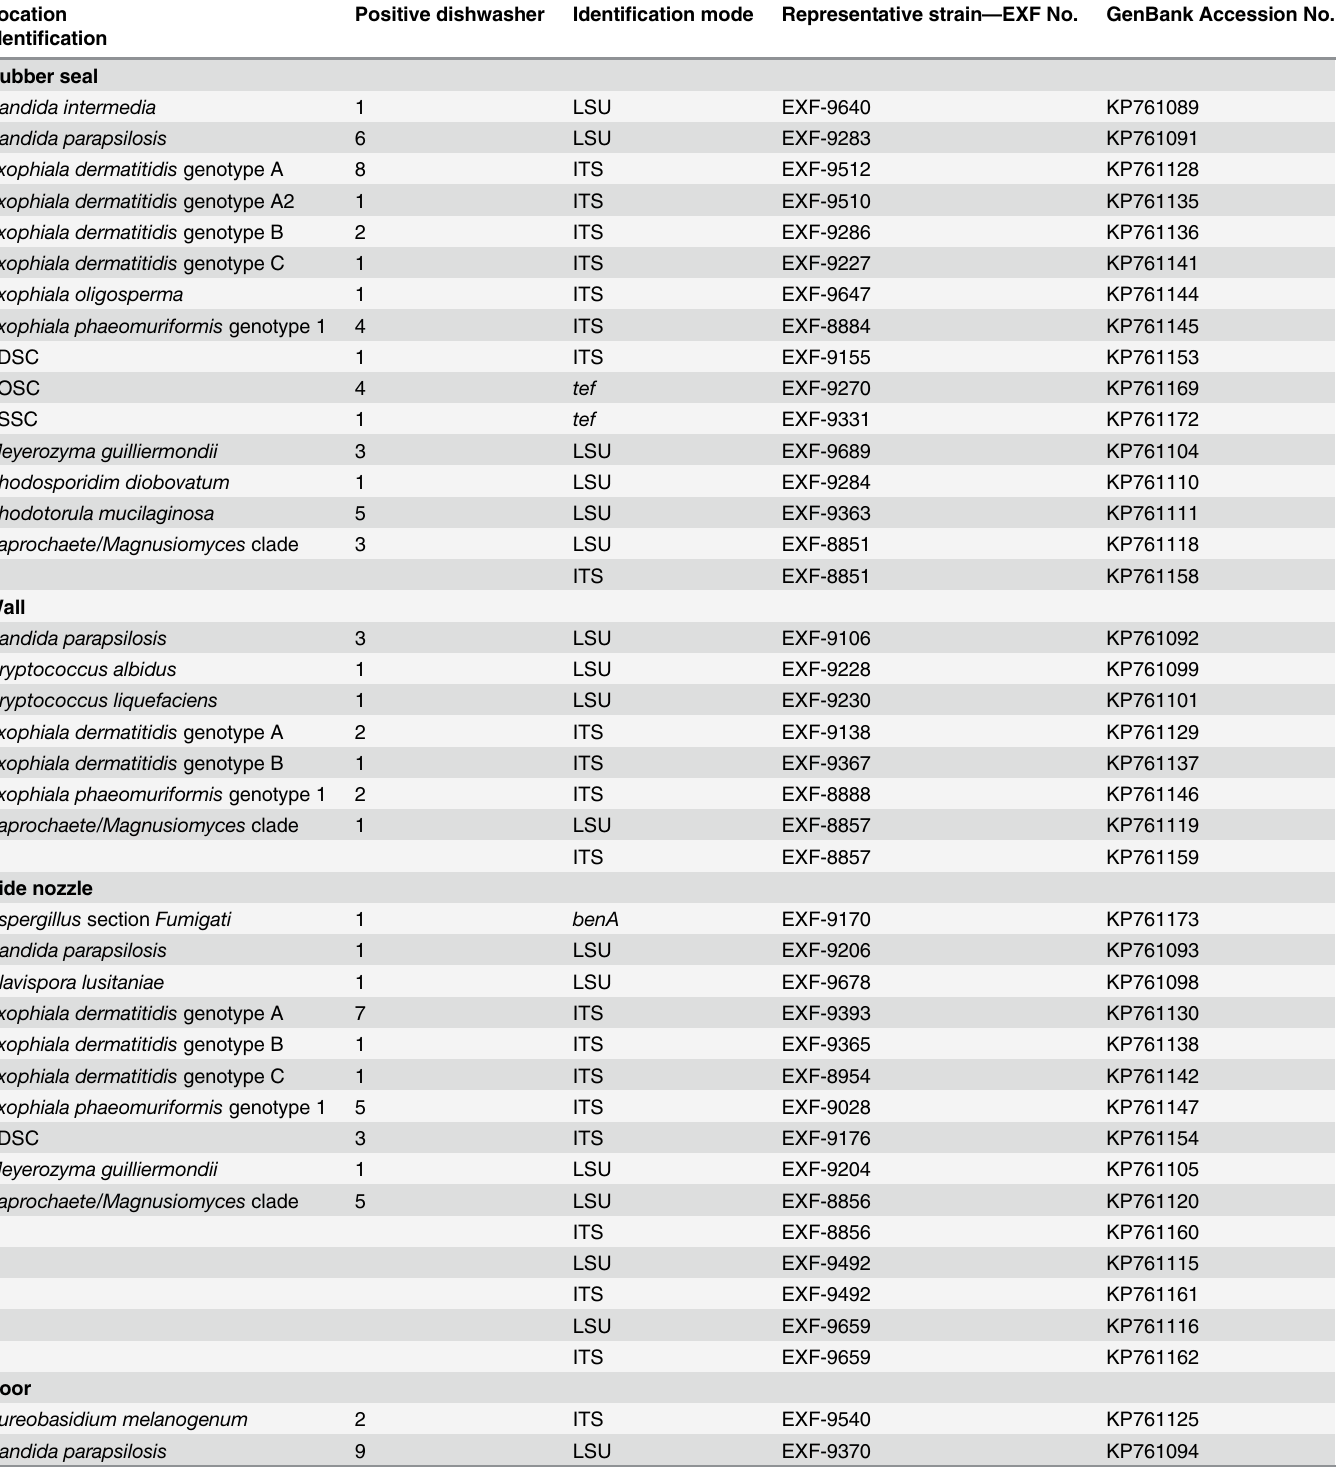
Table 2. Frequency of occurrence of strains and their sampling sites and GenBank accession numbers from the 30 residential dishwashers sam- pled in the present study.